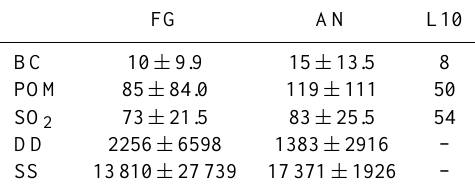
Table 5. Total emission fluxes of first guess (FG) and analysis (AN) for the year 2002 of black carbon (BC), particulate organic matter (POM), desert dust (DD), sea salt (SS) and sulphur dioxide (SO 2 ). Fluxes and errors are given in Tgyr − 1 and the latter correspond to one standard deviation. The fluxes for SO 2 are given in TgSyr − 1 . The emission fluxes presented in Lamarque et al. (2010) are referred as L10. To ease the comparison we have converted organic carbon (OC) emissions given in Lamarque et al. (2010) to POM as used in this study. We use a conversion factor of 1.4 between both